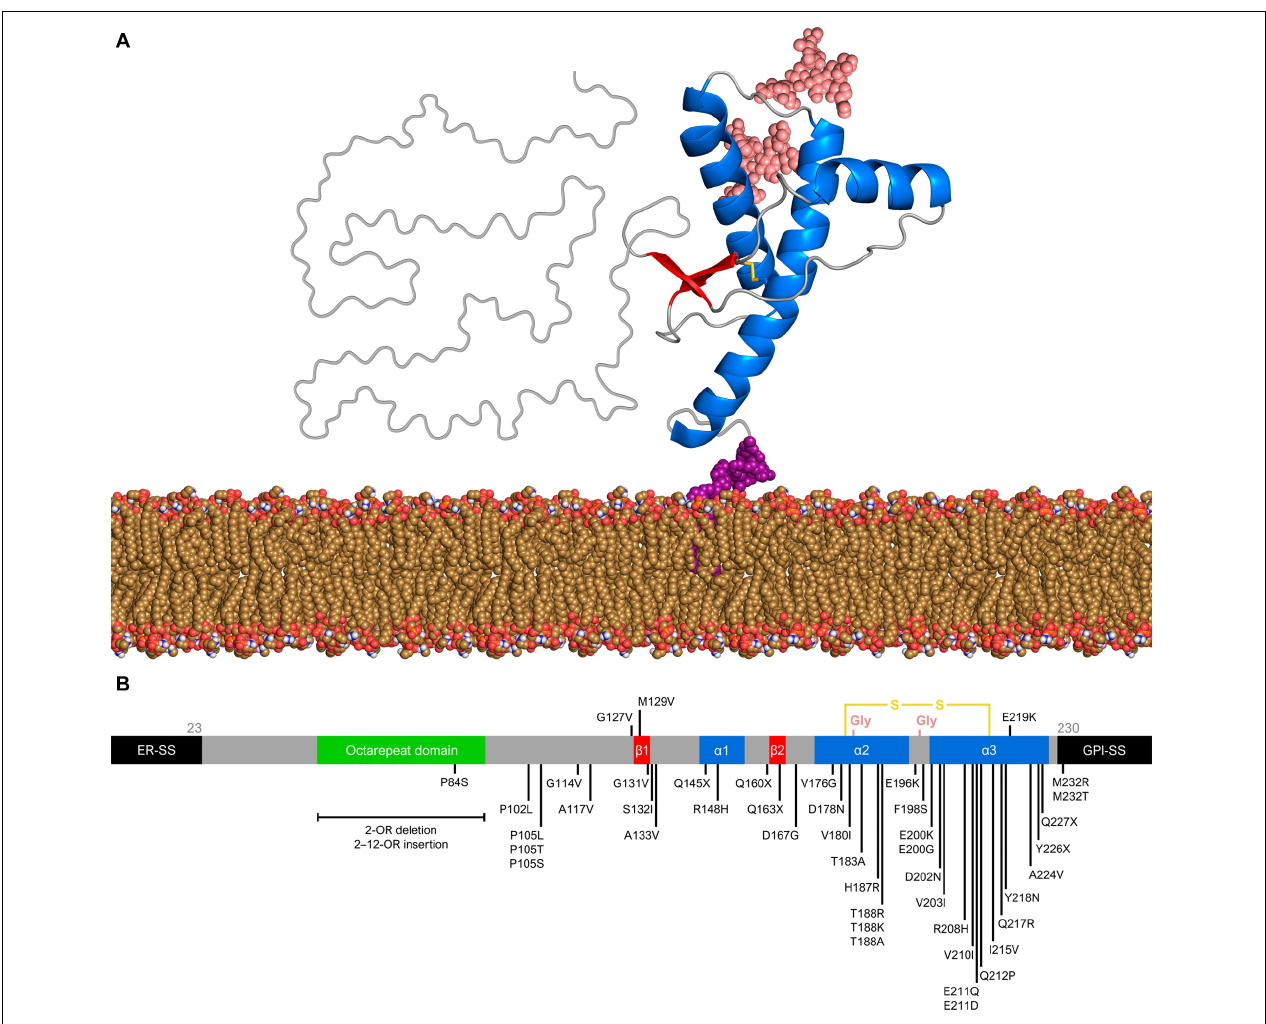
FIGURE 1 | Prion protein structure and genetic variation. (A) Diglycosylated, full-length human PrP C (huPrP 23 − 230 ) attached to the membrane (yellow brown) by a GPI anchor (purple). The globular C-terminal domain comprises three α -helices (blue) and two small β -strands (red), while the N-terminal is intrinsically flexible. Turns and random coils are represented in gray, and the glycosides are shown in salmon. A disulfide bond (yellow) connects the α -helices 2 and 3. The globular domain structure was determined by nuclear magnetic resonance (PDB code 1QLX). (B) Schematic of human PrP primary structure, with disease-associated mutations (below) and polymorphisms (above). Deleterious mutations include missense and nonsense changes, as well as octarepeat insertions and deletions. The octarepeat domain (green) is a copper-binding segment of 4–5 contiguous repeats of the sequence PHGGGWGQ. The 22-residue endoplasmic reticulum signal sequence (ER-SS) and 23-residue GPI signal sequence (GPI-SS) at the ends are shown in black. The other portions are colored as in panel (A)